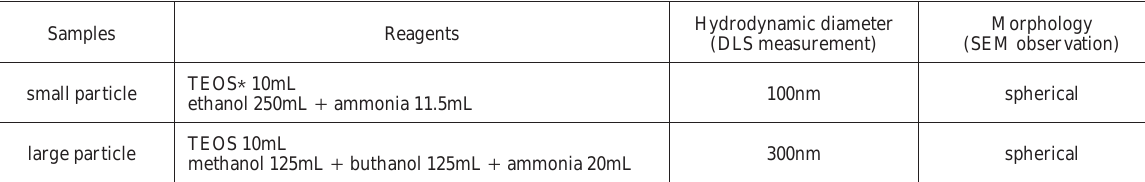
Table 1 Particle characteristics used in the